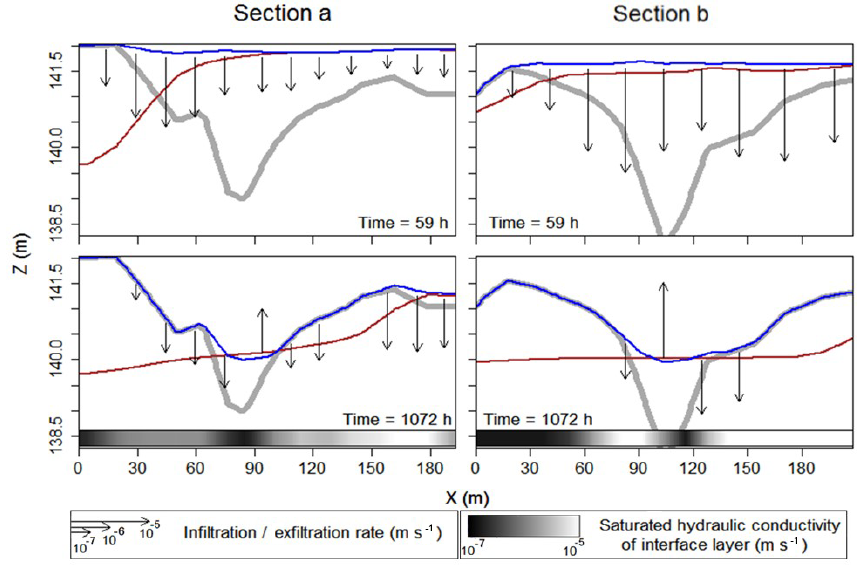
Figure 9. Evolution of surface water elevation (blue), groundwater head (red), and exchange fluxes (arrows) along transects a and b (located in Fig. 7) at two periods (hours after the beginning of injection) of the calibration period. A thick grey line represents the topographic profile. The grey scale indicates values of the saturated hydraulic conductivity at the interface between surface and subsurface.